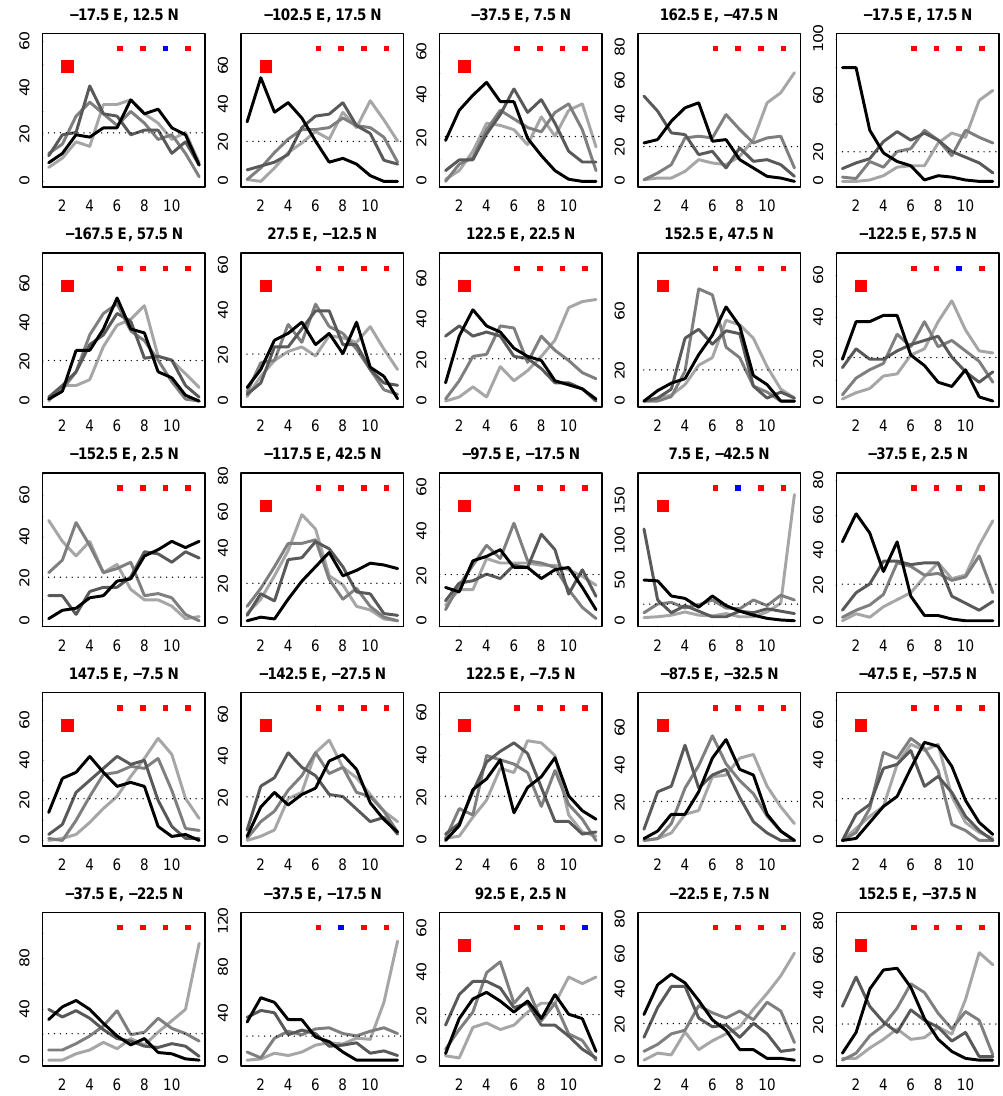
Fig. 8. Rank histogram counts for a random selection of 25 grid points from the decadal smooth global temperature data and the first, second, third and last 250 non-overlapping records of the decadally smoothed annual data (grey to black lines, about 800 to 1050, 1050 to 1300, 1300 to 1550, and 1595 to 1845). Large (small) red squares mark grid points where spread or bias deviations are significant over the full period (the individual sub-period). Blue squares indicate non-significant deviations. Squares in each panel from left to right for the first, second, third and last sub-period. Locations given in titles of individual